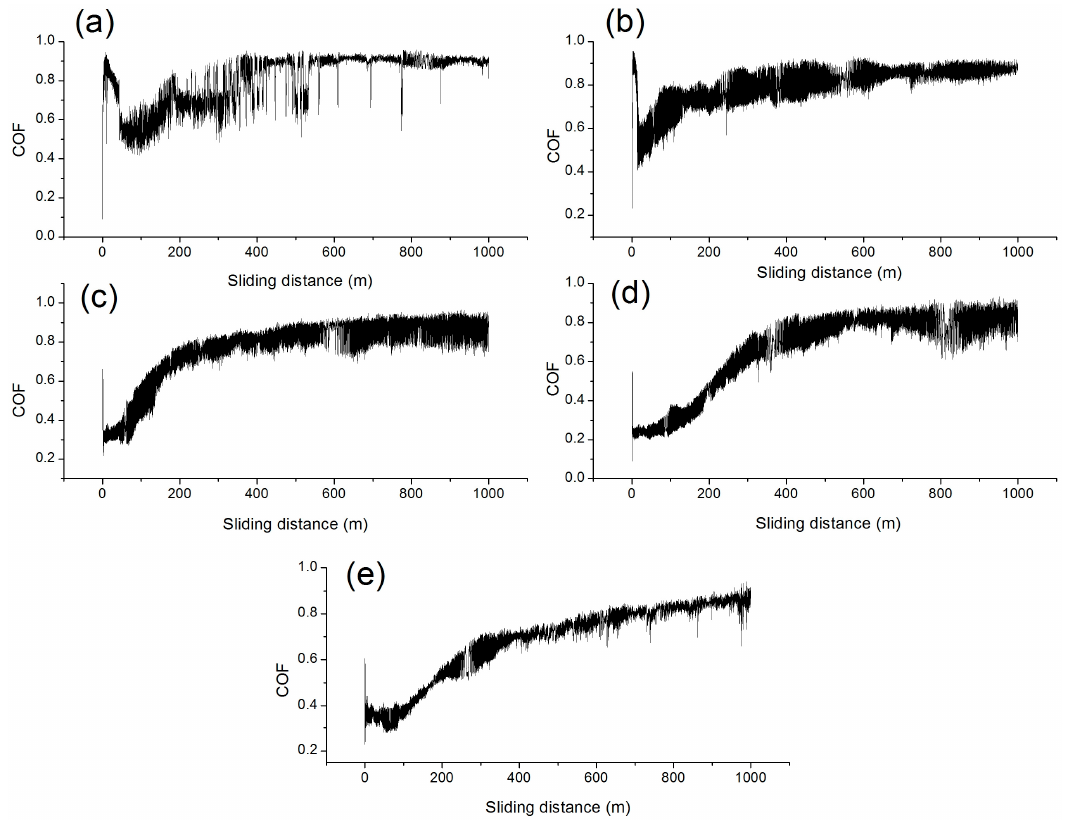
Figure 4. The COF traces for ( a ) BMG; ( b ) BMG-1 wt % graphite; ( c ) BMG-2 wt % graphite; ( d ) BMG- 3 wt % graphite; ( e ) BMG-4 wt % graphite composites under a normal load of 20 N.